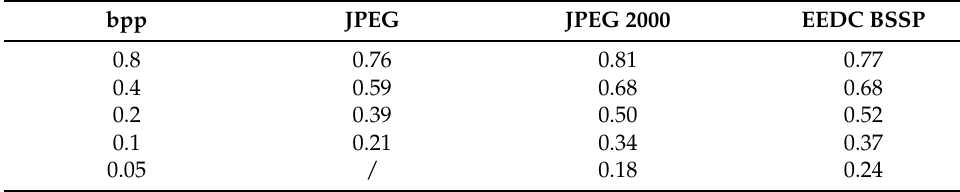
Table 20. Results of the VIF metric for image pills